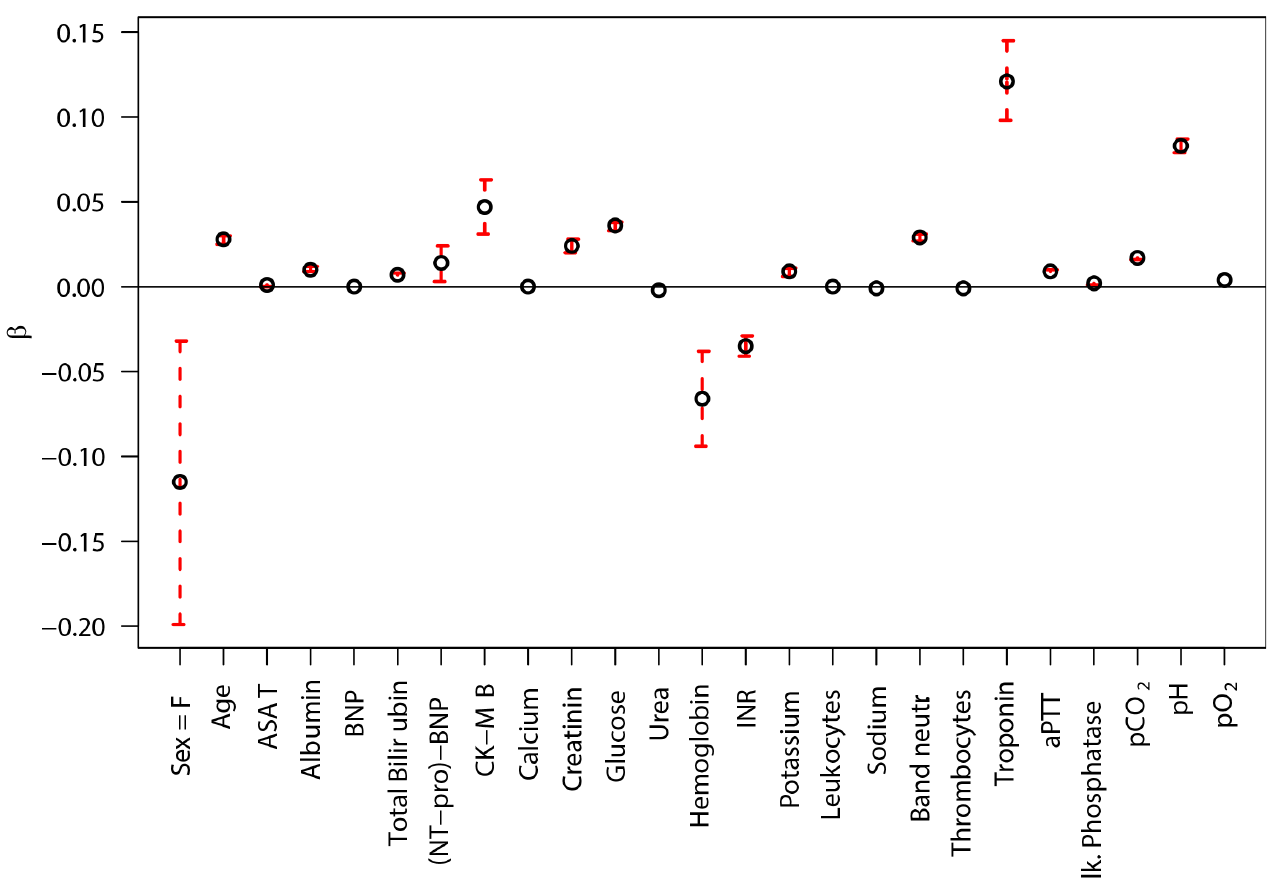
Fig 2. Absolute values of model parameters, along with 95% confidence intervals, for the GEE